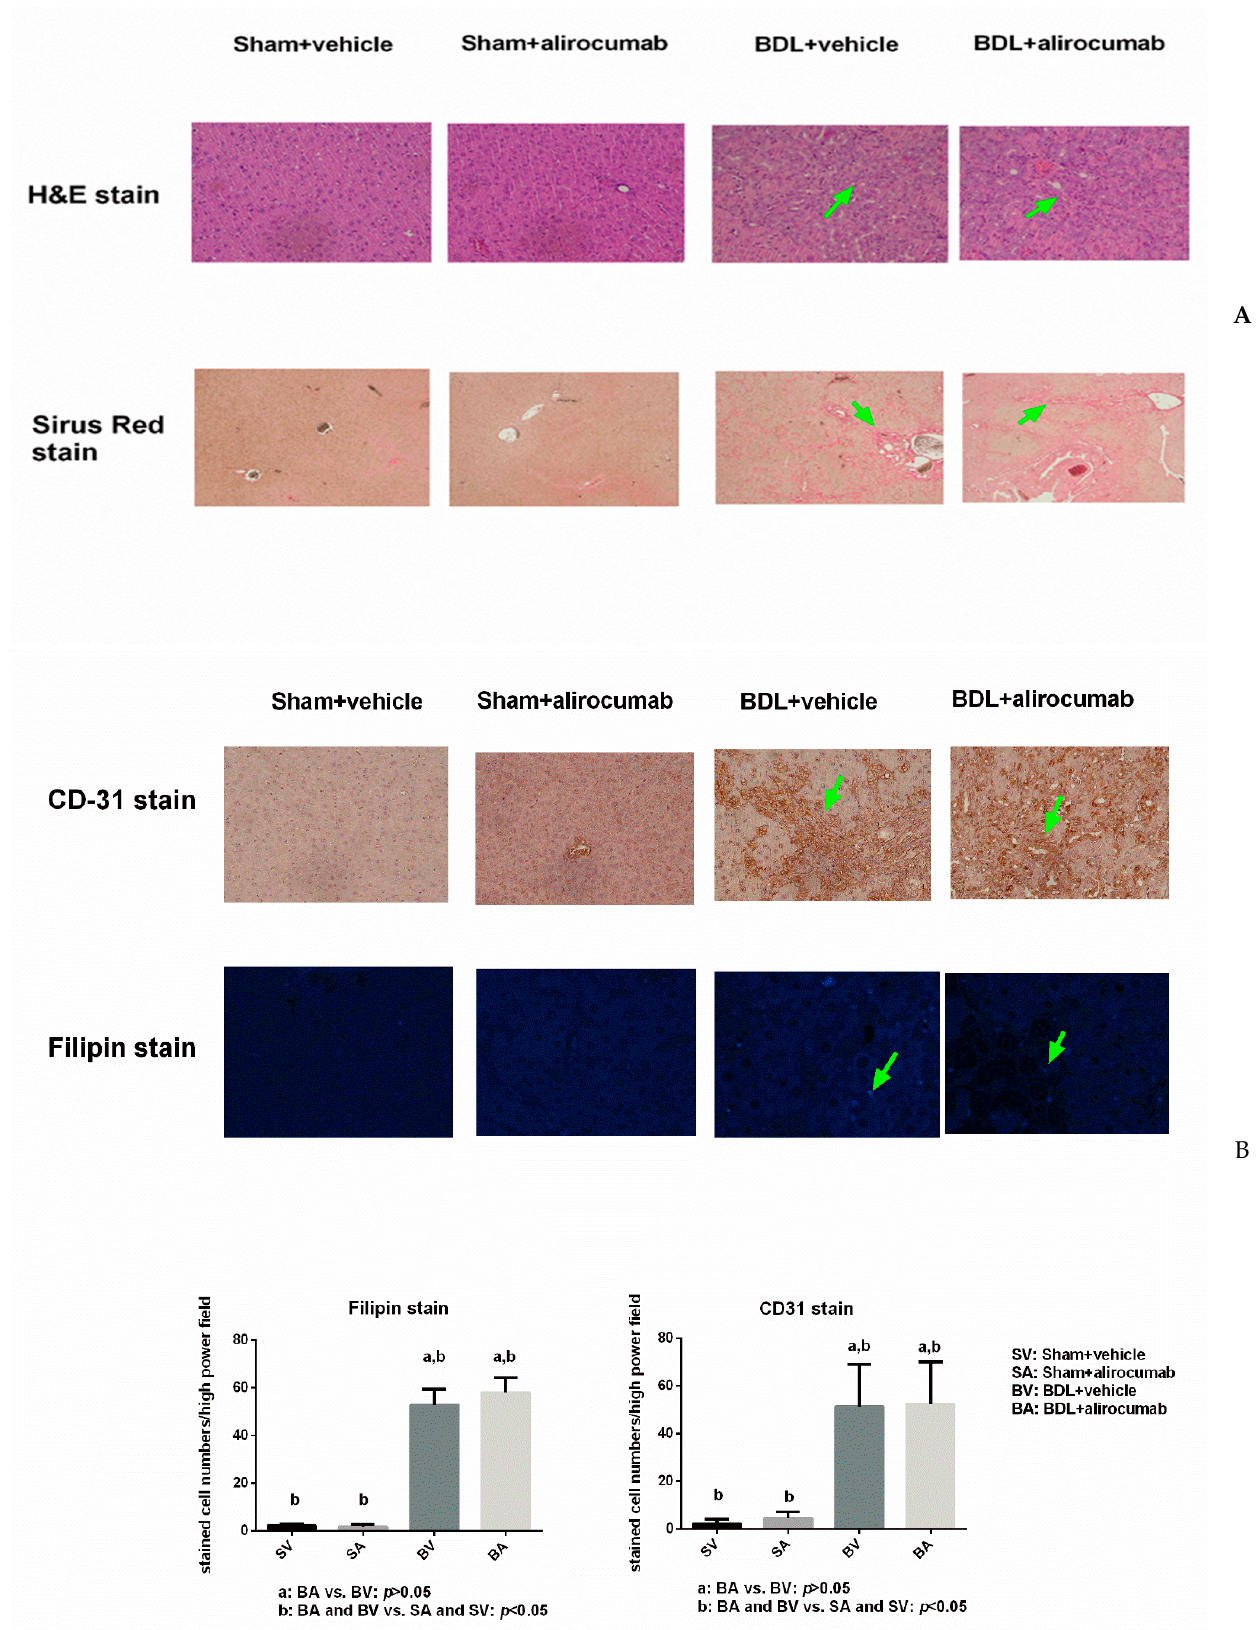
Figure 2. ( A ) Liver histology of sham or BDL rats with or without alirocumab treatment. The representative H&E staining image of sham rats showed normal architecture of liver tissue. In